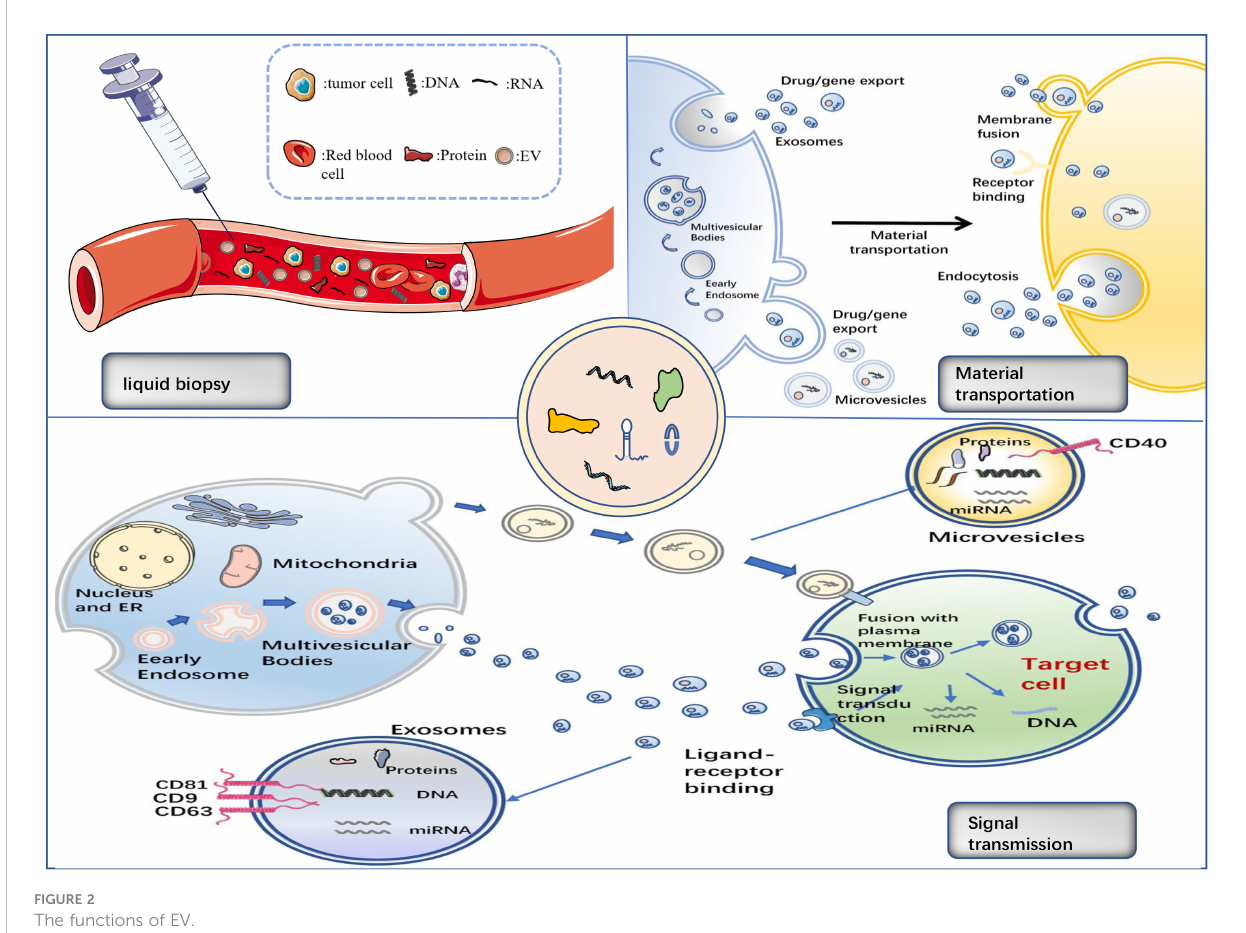
FIGURE 2 The functions of